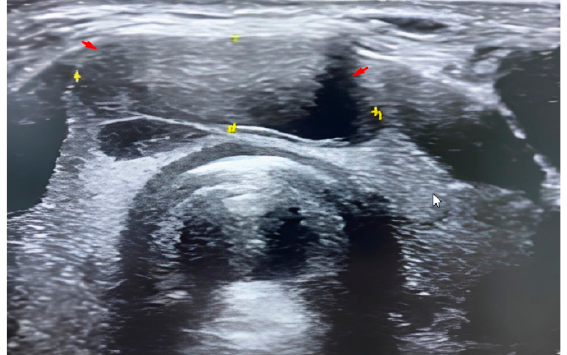
Figure 1. US imaging findings in benign lesion. Grayscale US image of the thyroid gland in a 16-year-old boy demonstrate isthmic solitary predominately cystic nodule with small solid component (red arrows).